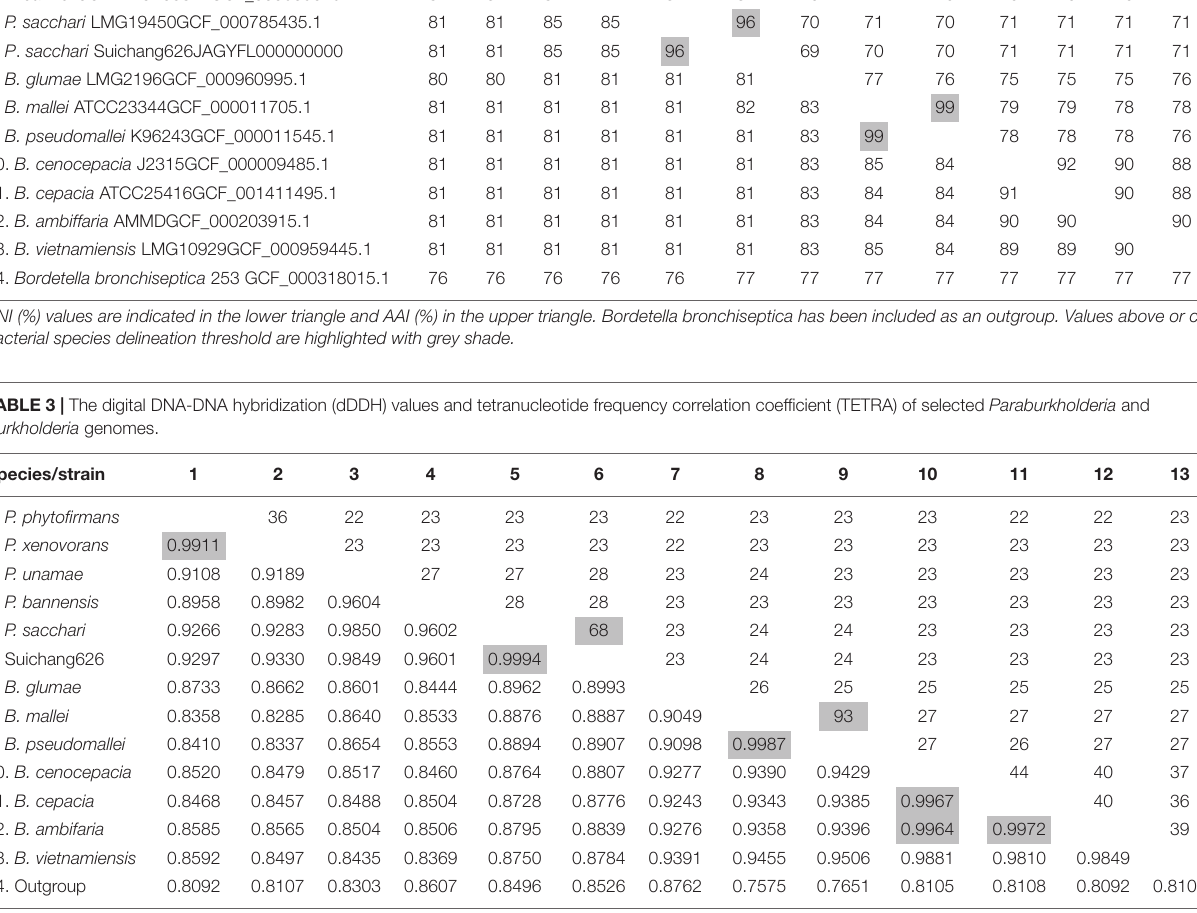
TETRA are indicated in the lower triangle and dDDH (%) in the upper triangle. Bordetella bronchiseptica has been included as an outgroup for comparison. Suichang626: P. sacchari Suichang626. Values above or close to bacterial species delineation threshold are highlighted with grey shade.